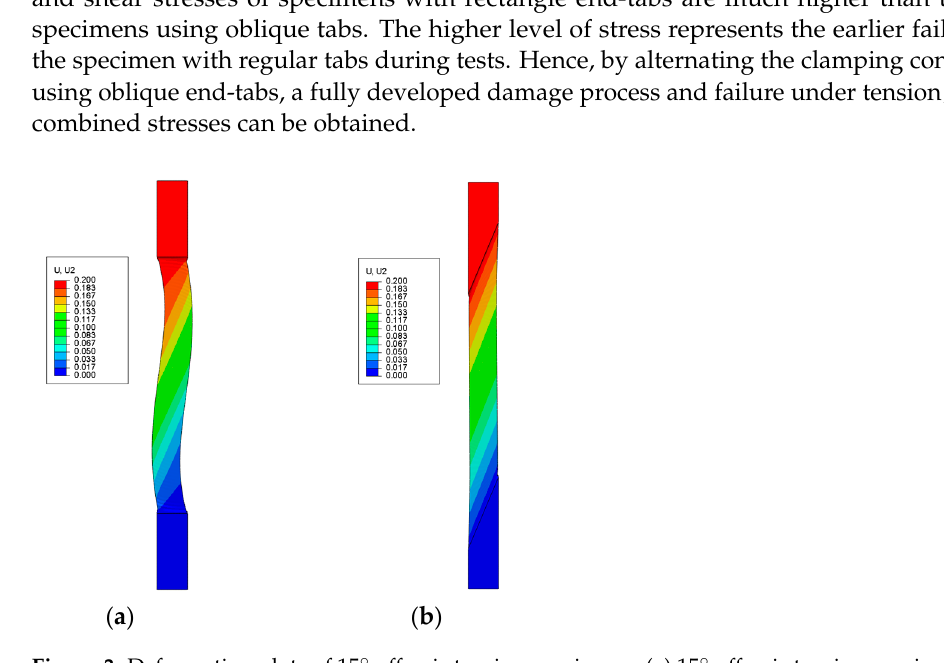
Figure 3. Deformation plots of 15° off-axis tension specimens: ( a ) 15° off-axis tension specimen with rectangle end-tabs; ( b ) 15° off-axis tension specimen with oblique end-tabs. Figure 4a,b is the FE simulated stress contour plots of the 15° off-axis tension speci- men. For the specimen with rectangle end-tabs, clear stress concentration points can be